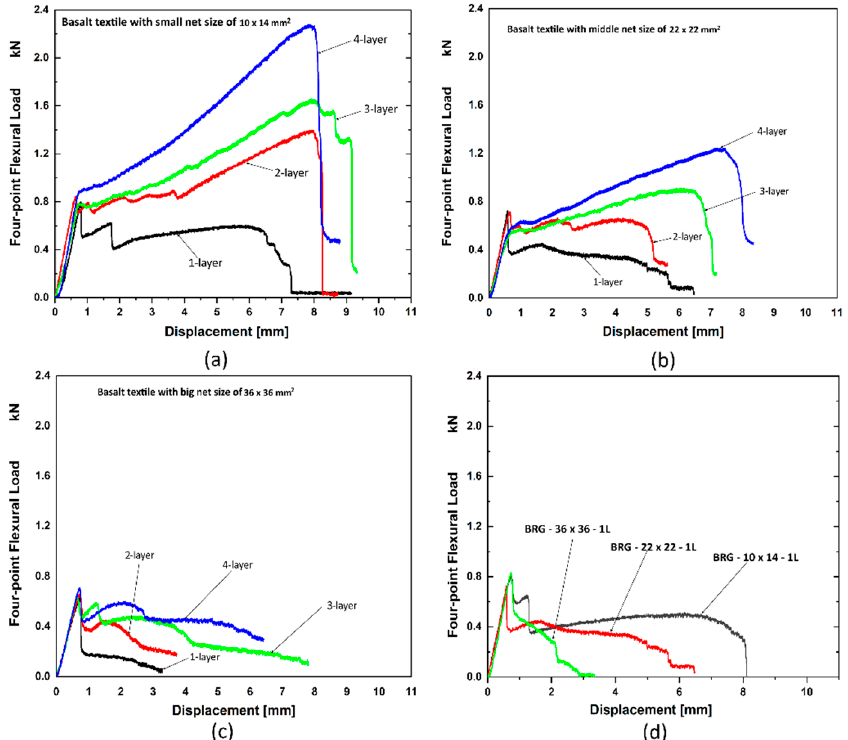
Figure 8. Flexural load – displacement curves of the specimens reinforced with the basalt textile having: ( a ) a net size of 10 × 14 mm 2 ; ( b ) a net size of 22 × 22 mm 2 ; ( c ) a net size of 36 × 36 mm 2 ; ( d ) comparison between one-layer reinforced specimens based on three.